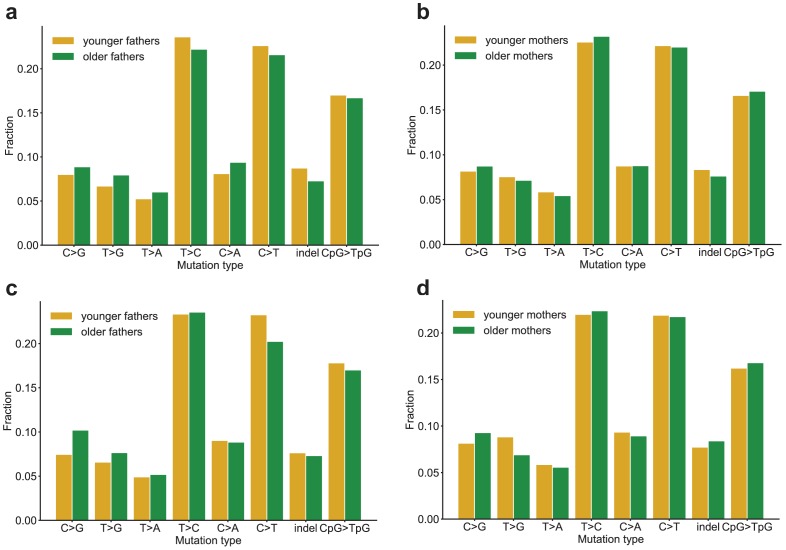
Comparison of mutation spectra in children born to older or younger parents.Second-generation children were divided into two groups based on the ages of their parents at birth, and autosomal mutation spectra were compared between the two groups. In all panels, no significant differences were found at a false-discovery rate of 0.05 (Benjamini-Hochberg procedure), using a Chi-squared test of independence. (a) Comparison of DNMs in children born to fathers younger (n = 2,182) or older (n = 2,360) than the median paternal age of 29.2 years. P-values for each comparison are: C > G: 0.304, T > G: 0.140, T > A: 0.306, T > C: 0.248, C > A: 0.8.81e-2, C > T: 0.444, indel: 6.89e-2, CpG >TpG: 0.810. (b) Comparison of DNMs in children born to mothers younger (n = 2,225) or older (n = 2,317) than the median maternal age of 25.7 years. P-values for each comparison are: C > G: 0.580, T > G: 0.659, T > A: 0.554, T > C: 0.697, C > A: 0.918, C > T: 0.990, indel: 0.371, CpG >TpG: 0.678. (c) Comparison of DNMs in children born to fathers in the 25th percentile of youngest (n = 1,120) or oldest (n = 1,165) paternal ages (26.4 or 34 years). P-values for each comparison are: C > G: 1.73e-2, T > G: 0.428, T > A: 0.872, T > C: 0.979, C > A: 0.943, C > T: 7.77e-2, indel: 0.788, CpG >TpG: 0.706. (d) Comparison of DNMs in children born to mothers in the 25th percentile of youngest (n = 1,169) or oldest (n = 1,121) maternal ages (22.5 or 31.4 years). P-values for each comparison are: C > G: 0.327, T > G: 9.92e-2, T > A: 0.841, T > C: 0.975, C > A: 0.963, C > T: 0.940, indel: 0.598, CpG >TpG: 0.780.